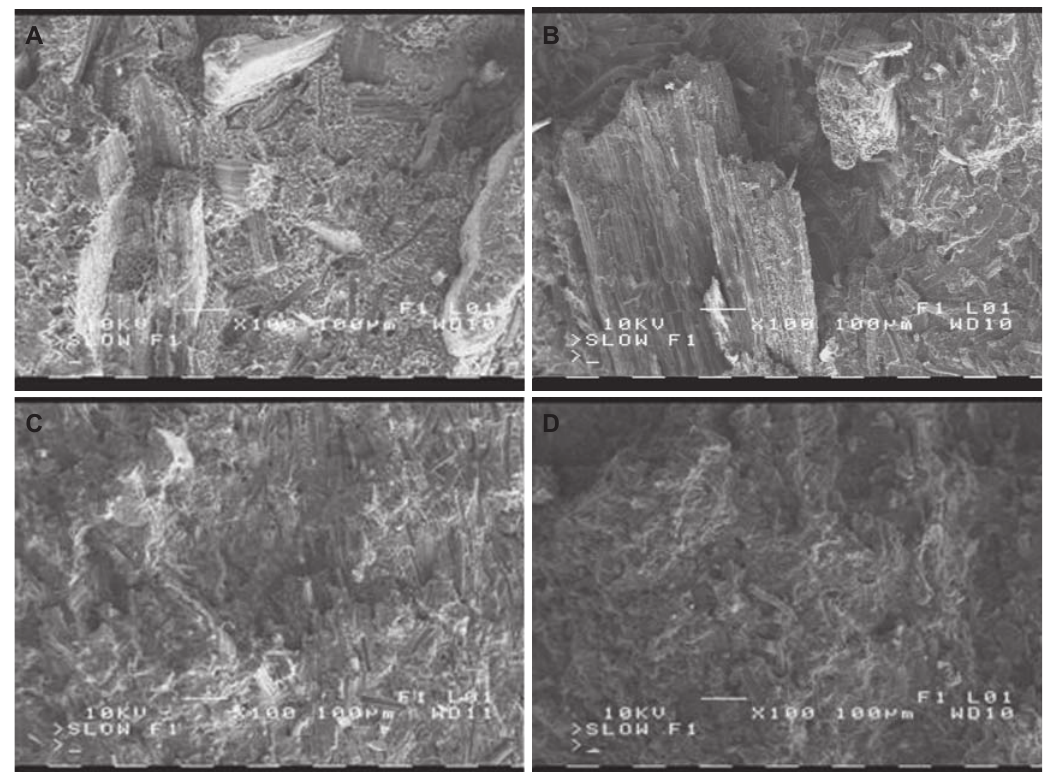
Figure 5 SEM photos of fractured fl ax/PP composites reinforced with (A) F30, (B) F10, (C) F0 and (D)